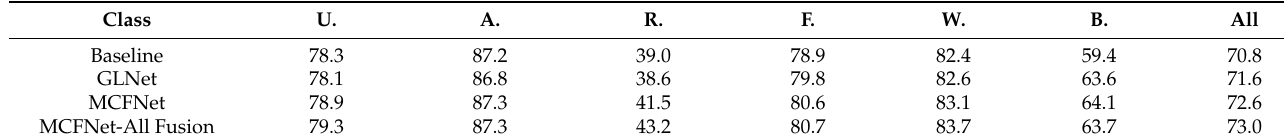
Table 3. Segmentation performance measured in IoU/mIoU(%) on DeepGlobe.